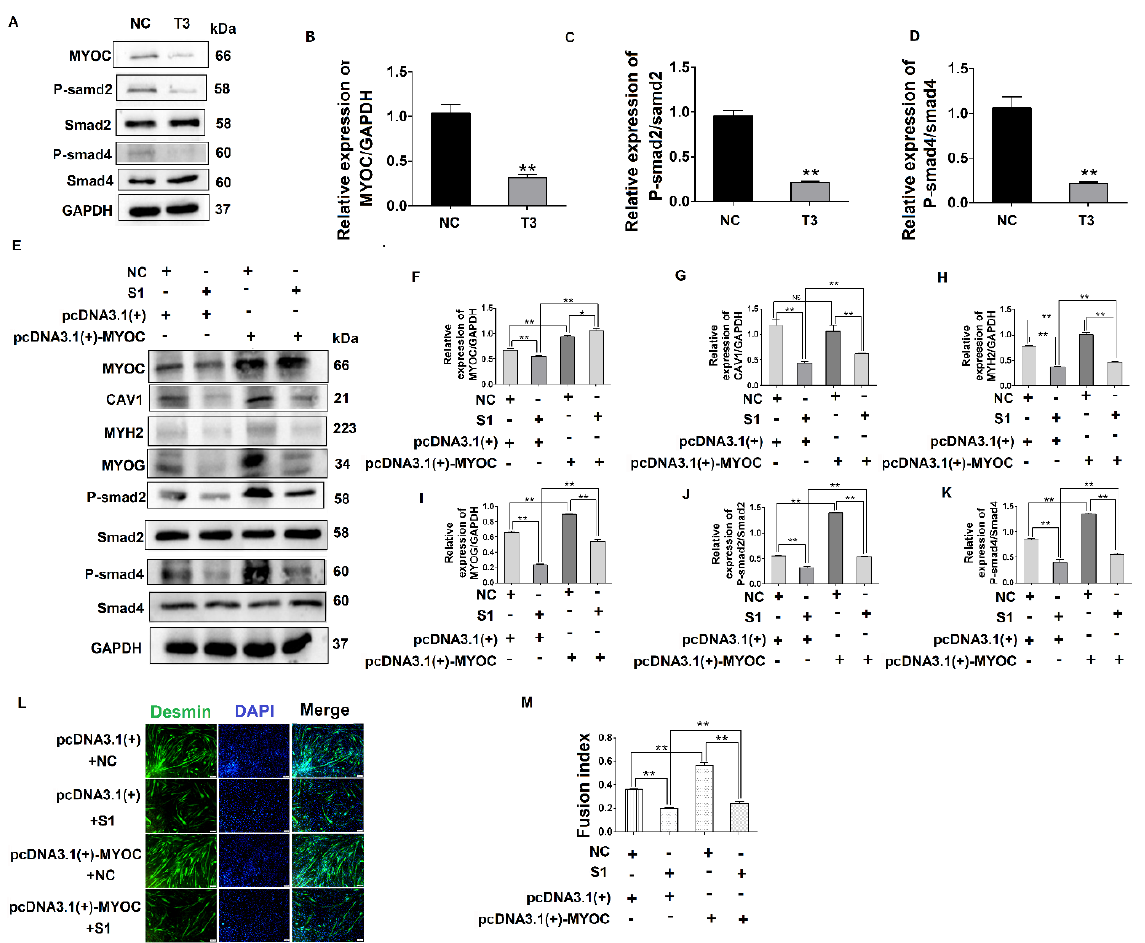
Figure 5. MYOC exerts an effect on the differentiation of C2C12 cells by regulation of CAV1 that affects the TGF- β pathway. ( A ). Change in MYOC, P-Smad2, and P-SMad4 expression after transfection of siRNA-sequence T3 for MYOC silencing. ( B ). Grayscale scan of MYOC in Figure A. ( C ). Grayscale scan of P-Smad2 in Figure A. ( D ). Grayscale scan of P-Smad4 in Figure A. ( E ). Western blotting of all indices in the co-transfection experiment control group and 3 experimental groups. ( F ). Grayscale scan of MYOC in Figure E. ( G ). Grayscale scan of CAV1 in Figure E. ( H ). Grayscale scan of MYH2 in Figure E. ( I ). Grayscale scan of MYOG in Figure E. ( J ). Grayscale scan of P-Smad2 in Figure E. ( K ). Grayscale scanning of P-Smad4 in Figure E. ( L ). Change in rate of fusion of myotubes after co-transfection, as measured by laser confocal microscopy. ( M ). Myotubule fusion rate in Figure L. (** p values < 0.01, * p values < 0.05) ( n = 3).